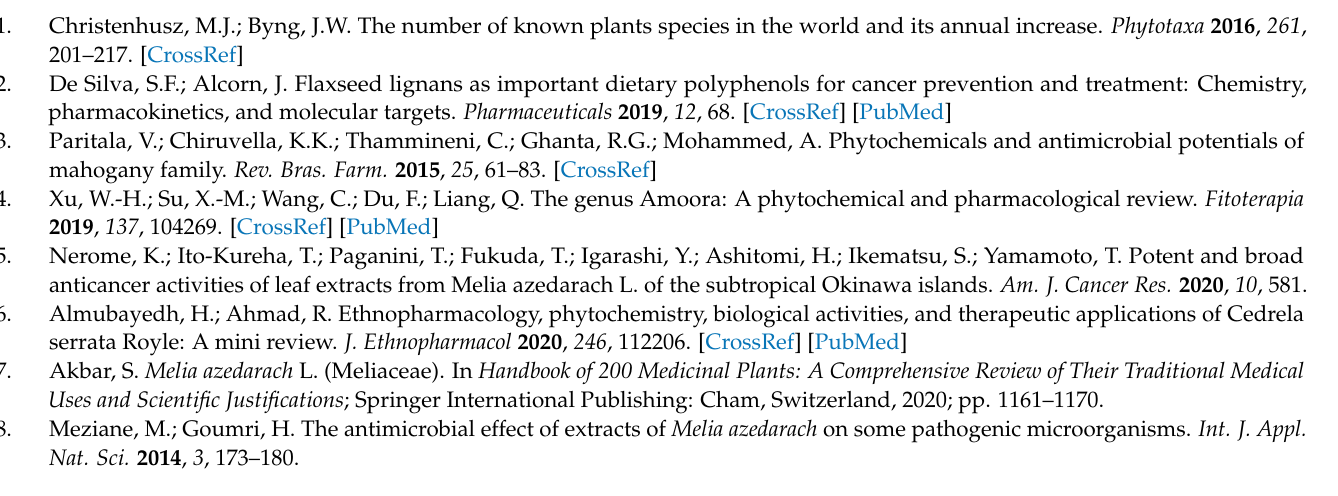
Figure S1: Hierarchical unsupervised clustering analysis heat map built by considering the phyto- chemical profile of the three different extracts of Meliaceae species under investigation. Figure S2: Average MIC values recorded for the tested extracts of Aphanamixis polystachya and Melia azedarach in mg mL − 1 against five clinical isolates of Methicillin-resistant Staphylococcus aureus (MRSA); the results represent the mean of three replicates ± SD. Vancomycin showed average MIC values of 0.002 ± 0.0 mg.mL − 1 with the 5 tested MRSA strains. Unpaired t -test, p -value < 0.0001. Figure S3: Inhibition of pigmentation of MRSA-3 and MRSA-5 by extracts of Aphanamixis polystachya was more pronounced than the effect of Melia azedarach at concentration of either 0.5 × MIC or 0.25 × MIC: (A) 0.5 × MIC treated A. polystachya cells, (B) 0.25 × MIC treated A. polystachya cells, (C) Extract-untreated cells, (D) 0.5 × MIC treated M. azedarach cells and (E) 0.25 × MIC treated M. azedarach cells. Table S1: Each compound is provided with its relative abundance and composite mass spectrum. Table S2: A comprehensive list of potential VIP marker compounds, together with their VIP score (>1) and LogFC values obtained by comparing the significant metabolites of the 3 different Meliaceae species. Table S3: Pearson’s correlation coefficients regarding the different in vitro biological assays and the annotated phytochemical classes by untargeted